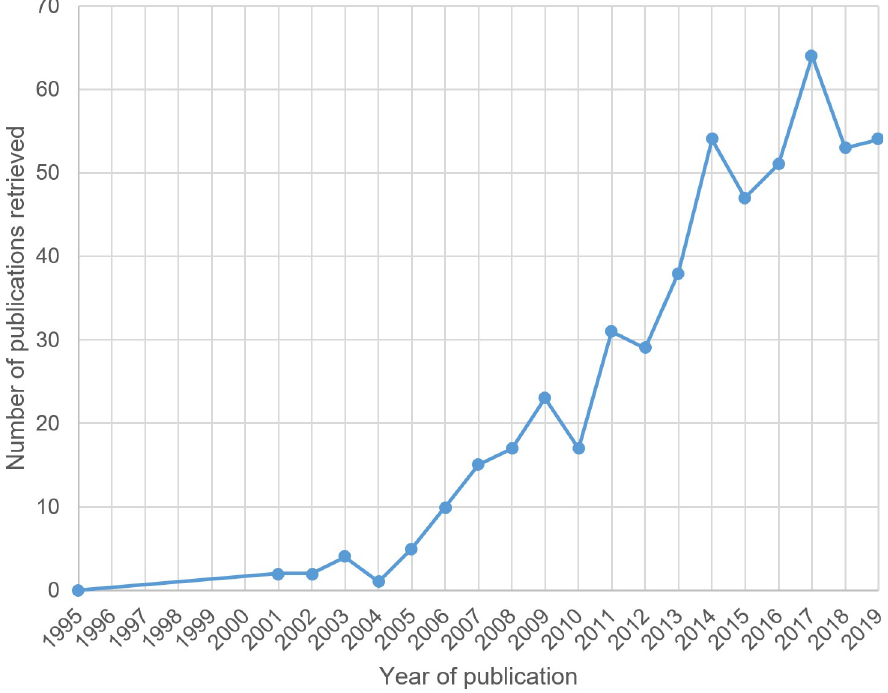
Fig 1. Growth in the occurrence of the combination of the terms ‘public engagement’ and ‘science’ in titles or abstracts in the Web of Science from 1995–2019 (N = 517).